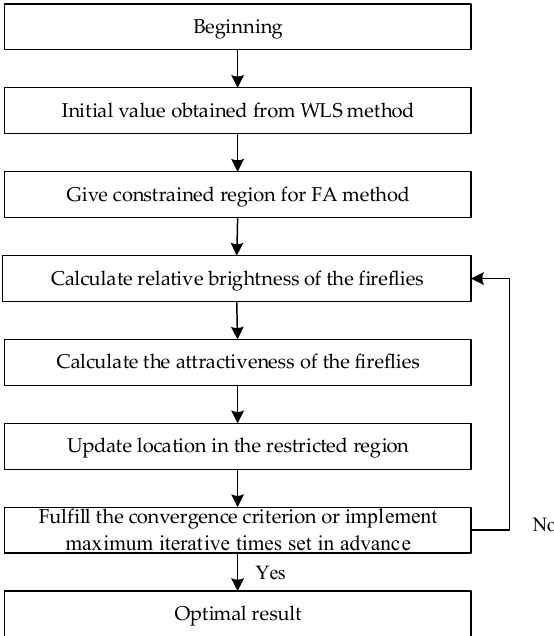
Figure 2. The diagram of hybrid firefly algorithm (hybrid-FA) method.